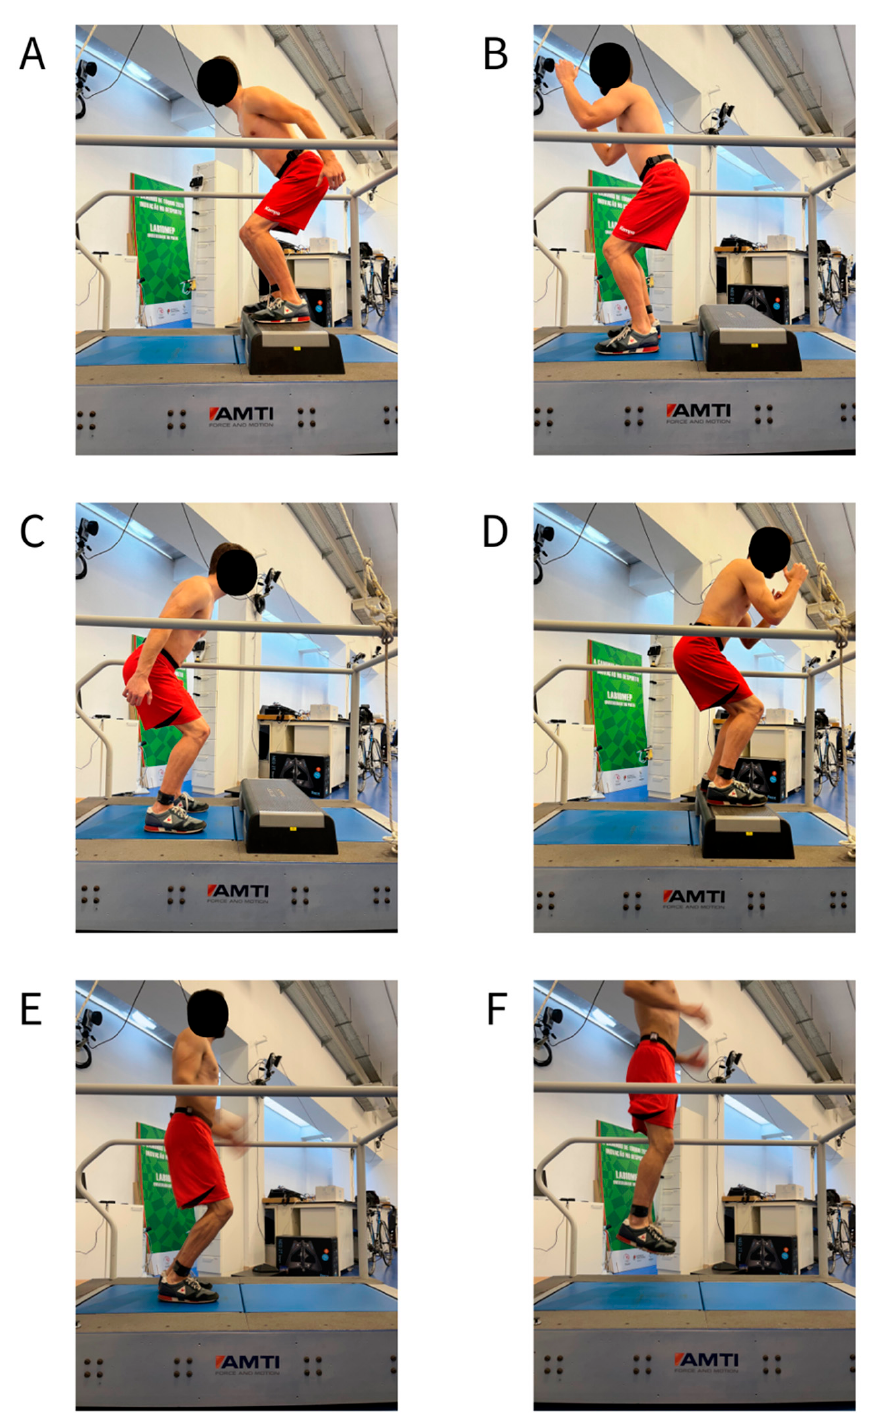
Figure 2. An example of a participant performing each of the jump types assayed. Panels ( A , B ) show the initial (take-off phase) and final (landing phase) phases of the drop jumps, respectively, while Panels ( C , D ) show the initial and final phases of the box jumps, respectively, and Panels ( E , F ) show the initial and final phases of the continuous jumps,